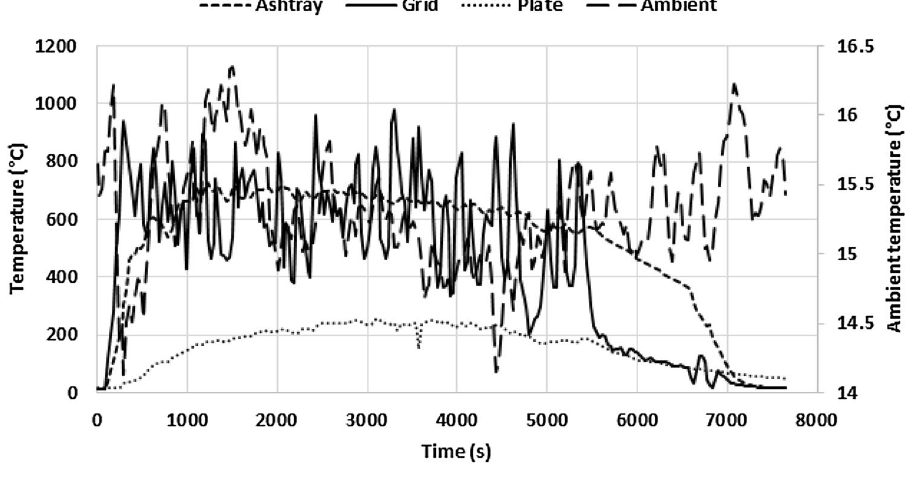
Fig. 4 Temperatures of the plate (dotted line), of the pot wall (solid line), of the water (hyphened line), and ambient, during a water ebullition test with the configuration of a